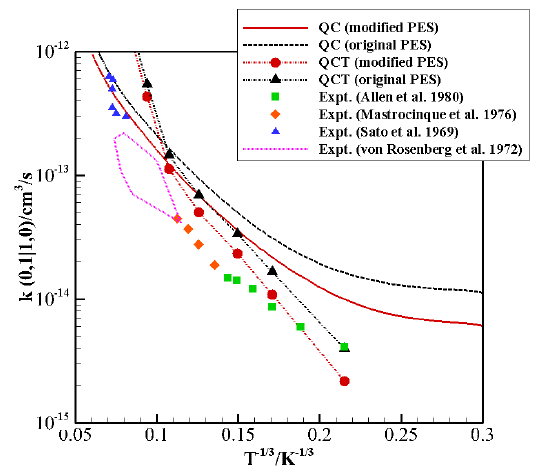
Figure 2. Landau–Teller plot of the rate coefficients for the transition (0,1) → (1,0) calculated by the QC method on the original PES (dash black line) and on the modified PES (full red line), and by the QCT method on the original PES (dash-dot black line with triangle symbols) and on the modified PES (dash-dot red line with circle symbols). Experimental data of (green squares) [41], (orange diamonds) [42], (blue triangles) [43], and (solid pink line) [44] are also reported.